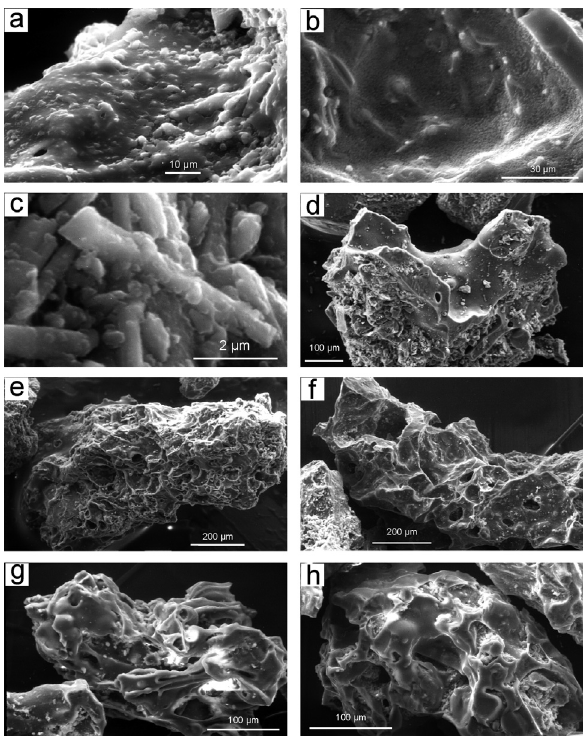
Figure 5. SEM images of the ash fragments in the ash layers (AS 95 118 and 122), showing the main feature of the clasts